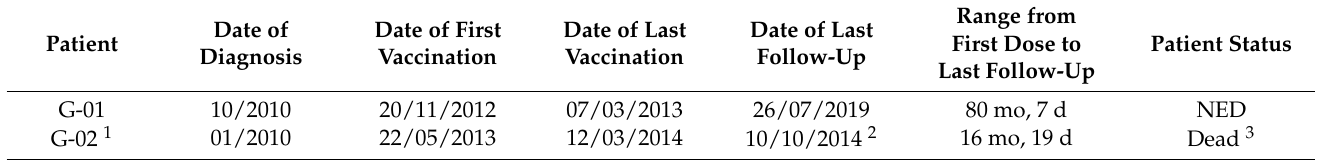
Table 3. Patient status and range of the first vaccine dose to the last